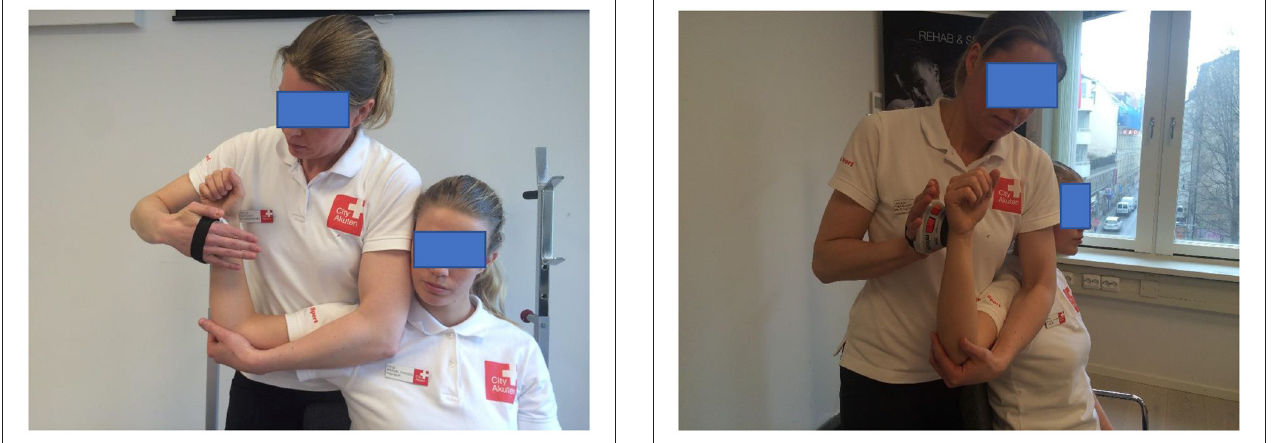
FIGURE 1 | Measurement of isometric muscle strength of the internal rotators using a hand-held dynamometer (CompuFET, Hoggan Health Industries Inc., Groningen, The Netherlands).